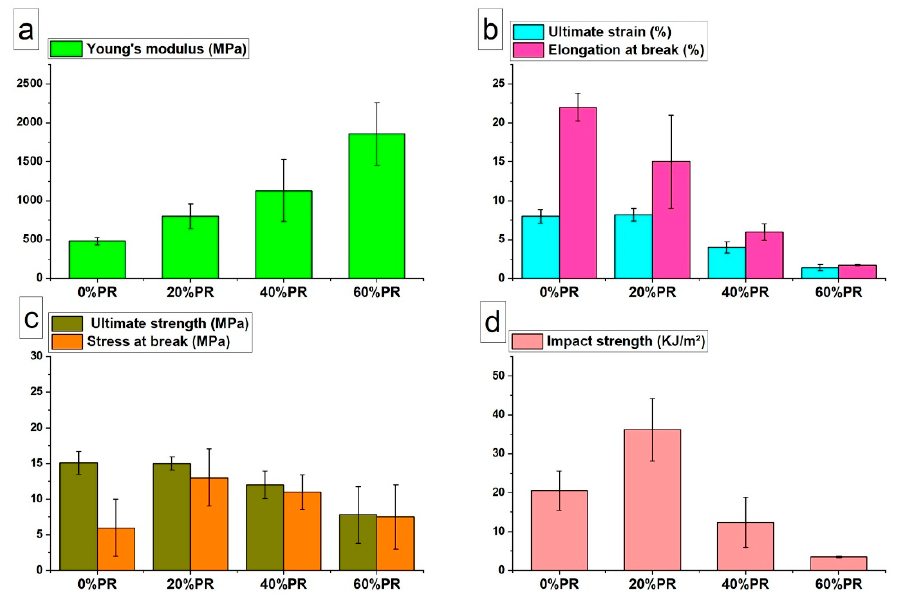
Figure 6. Tensile test results of 3D-printed specimens: ( a ) Young’s modulus, ( b ) ultimate strain and elongation at break, and ( c ) ultimate strength and stress at break. ( d ) Impact strength results from the impact test for 3D-printed specimens.